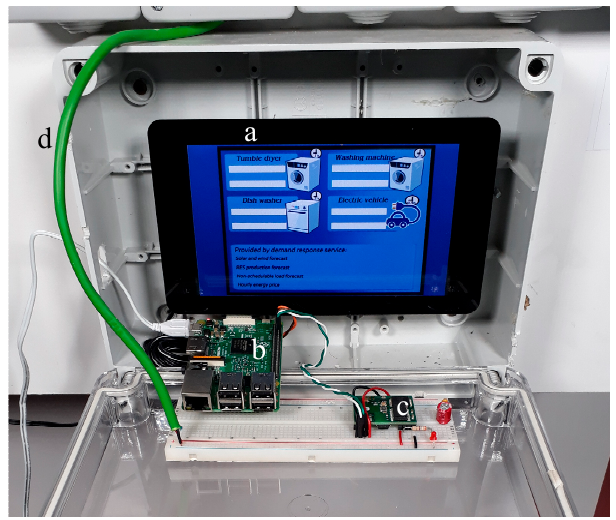
Figure 15. The high-EB prototype and ( a ) a touchscreen; ( b ) a Rasperry Pi3; ( c ) a Sim Tapko and ( d ) the STP cable.